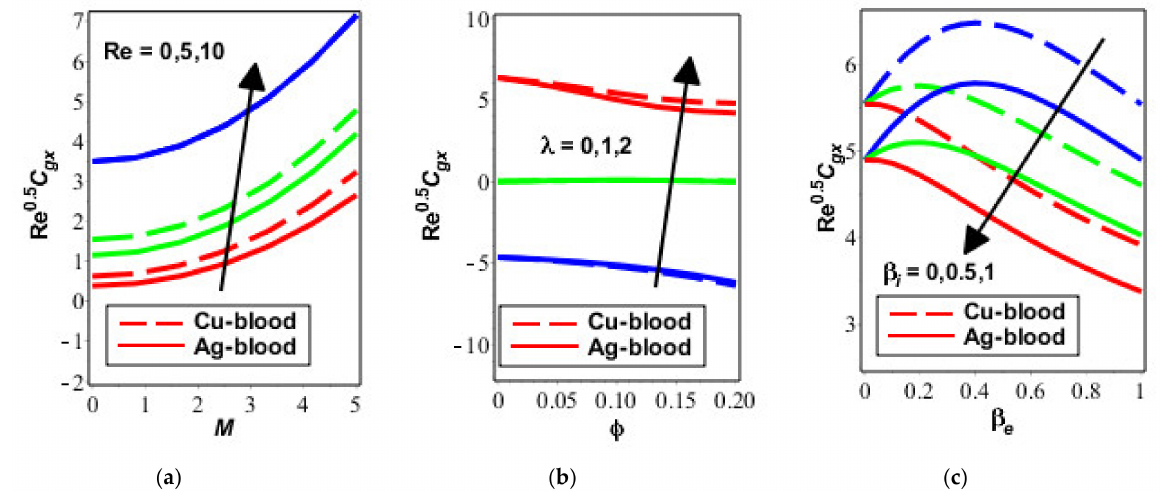
Figure 12. Behaviour of Re 1/2 C gx as varying ( a ) M and Re ( b ) φ and λ ( c ) β i and β e